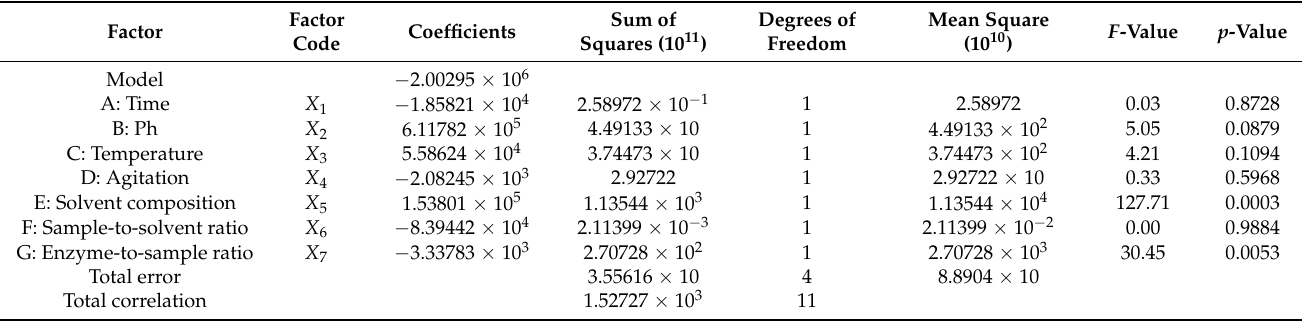
Table 3. Analysis of variance (ANOVA) of the Placket–Burman screening